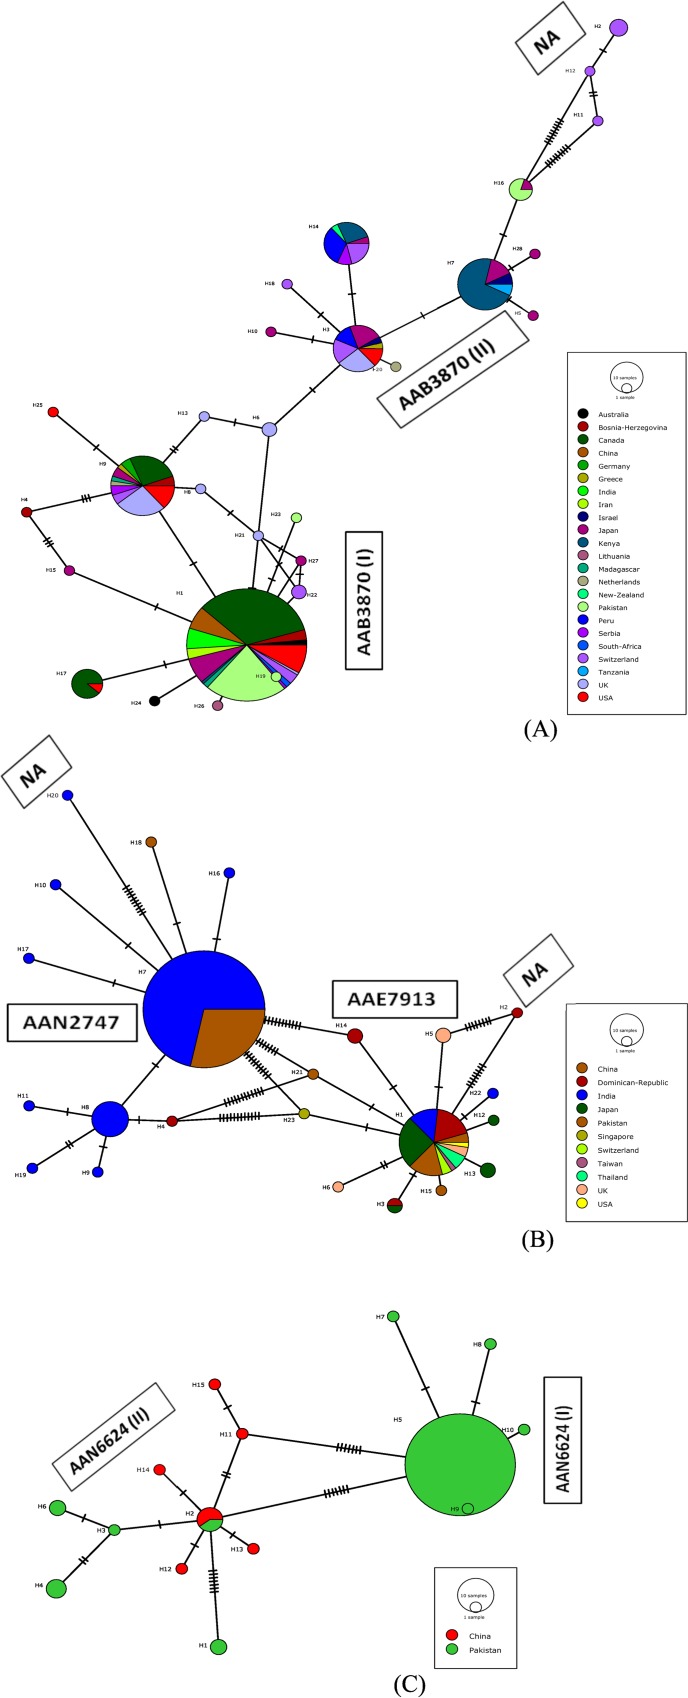
Haplotype networks for three species of pest thrips from Pakistan based on COI-5ʹ sequences including presumptive conspecifics from GenBank.A) Thrips tabaci; B) Thrips palmi; C) Thrips flavidulus. Different pie colors in the circles indicate the country of haplotype origin with pie size proportional to the number of records, while the circle sizes are proportional to the haplotype frequency in the dataset. Perpendicular tick marks on the lines represent the number of nucleotide substitutions between the linked haplotypes. Corresponding BINs are provided besides each haplotype cluster. NA = BIN not assigned.